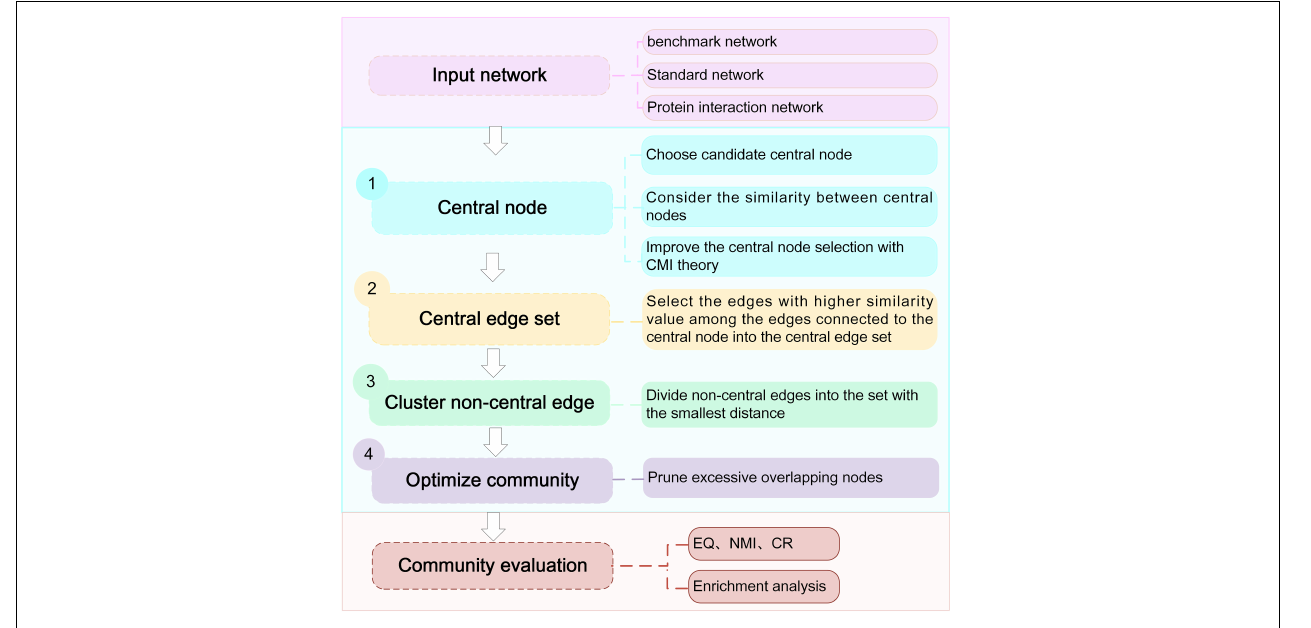
FIGURE 2 | Workflow of the NLC algorithm.